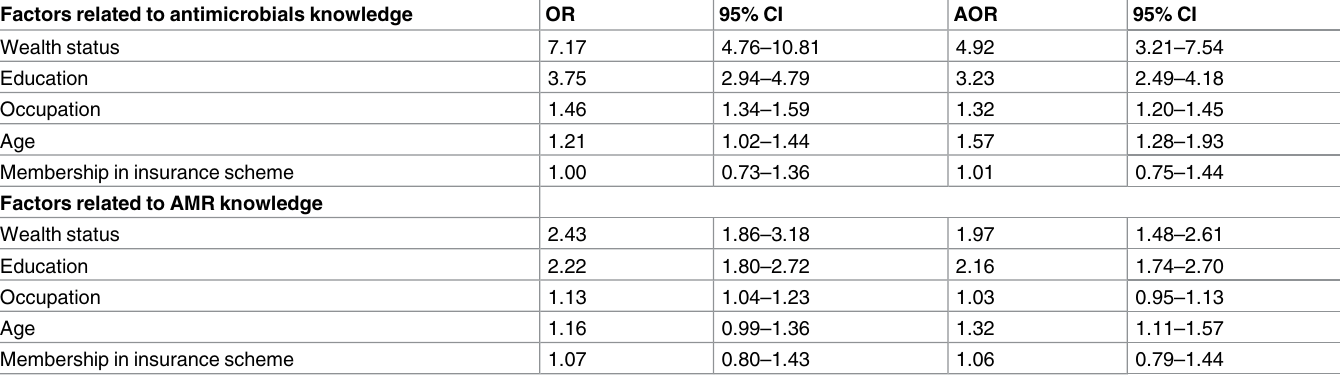
Table 4. Logistic analysis of factors influencing respondents’ level of knowledge of antimicrobials and AMR. Factors related to antimicrobials knowledge OR 95% CI AOR 95%